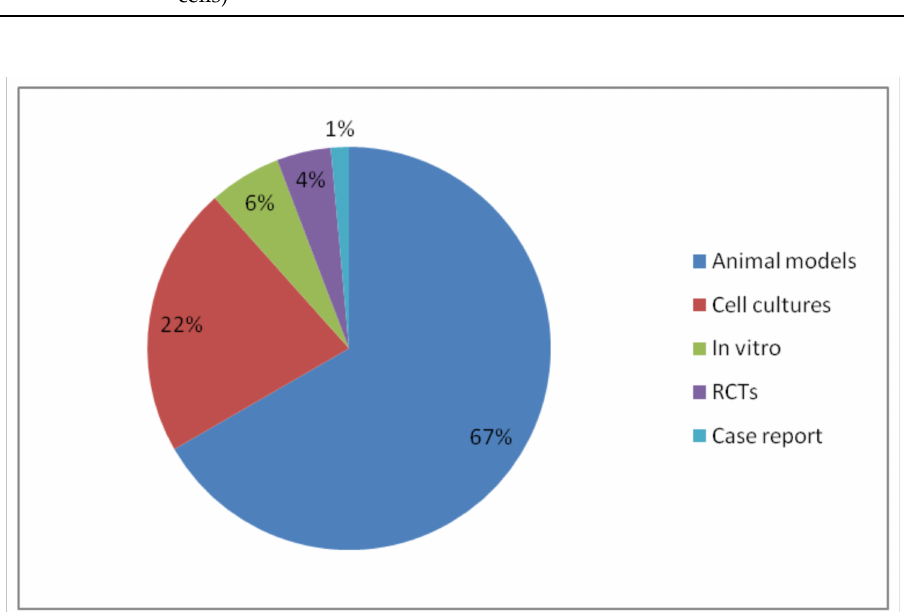
Figure 2. The percentages of the types of studies investigating the therapeutic use of propolis in the brain and in neurological disorders and